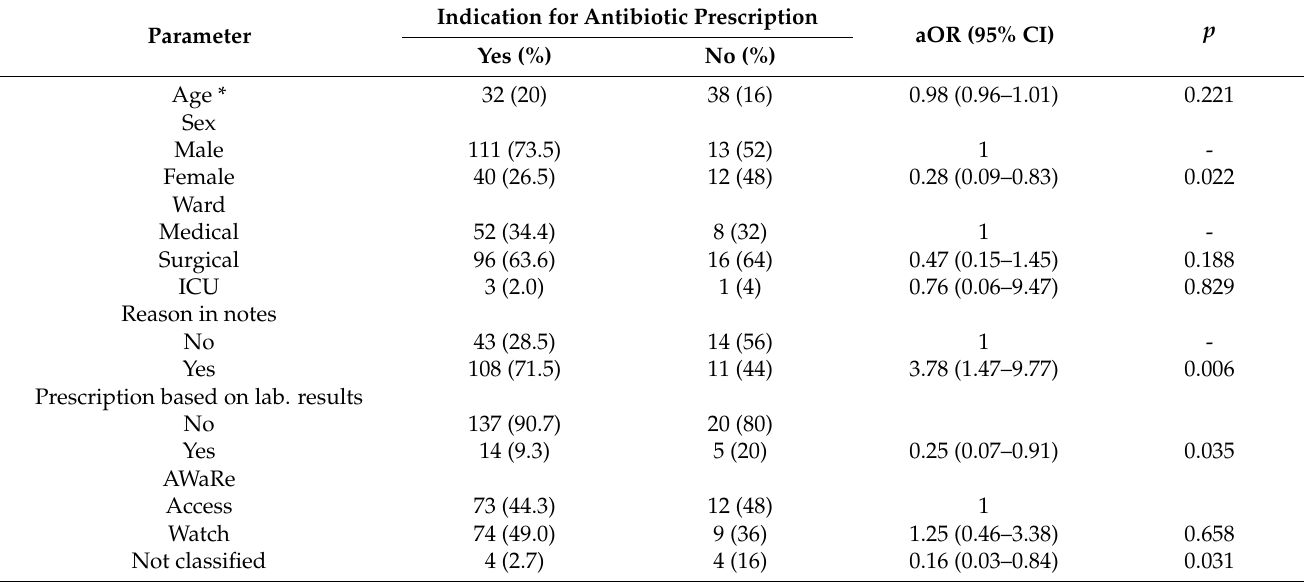
Table 3. Multivariable regression of presence of prescription